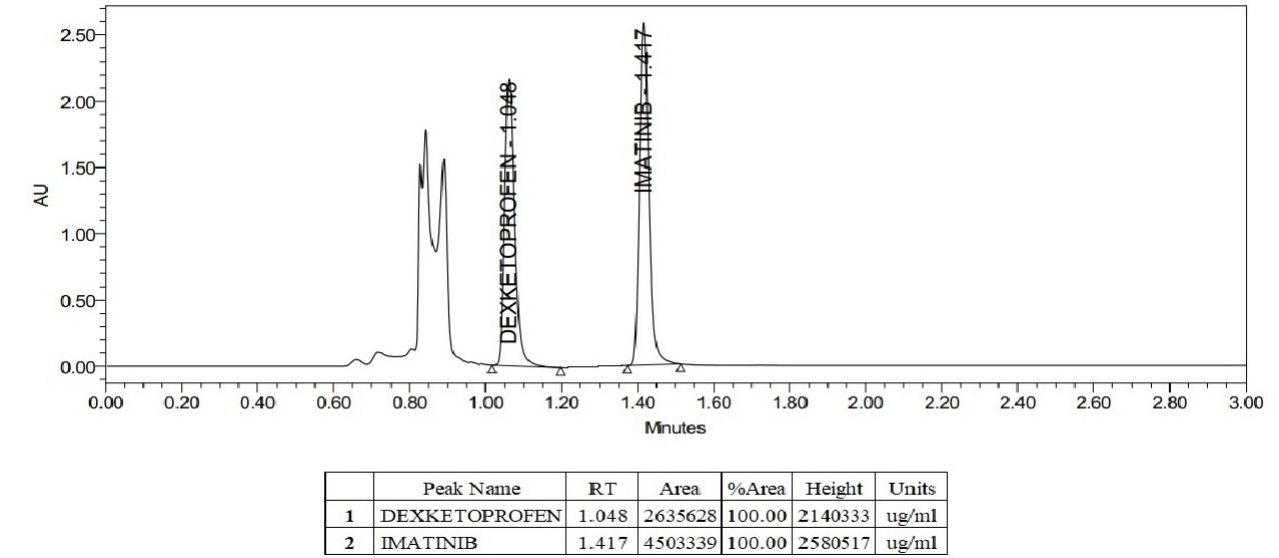
FIGURE 8 - UPLC chromatogram of dexketoprofen trometamol and imatinib mesylate in